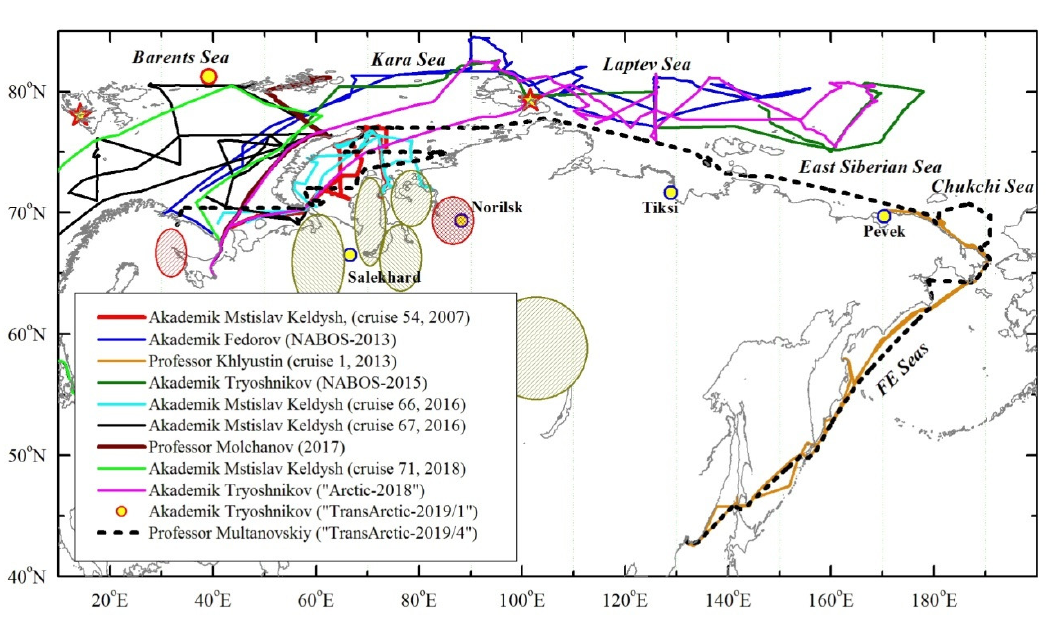
Figure 1. Routes of Arctic expeditions (circle indicates the region of drift in ice during “TA–2019/Stage 1”; stars indicate the polar stations “Barentsburg” and “Cape Baranov”; shaded areas indicate the main areas of extraction of mineral resources (gas, oil, etc.) production in the north of Russia.